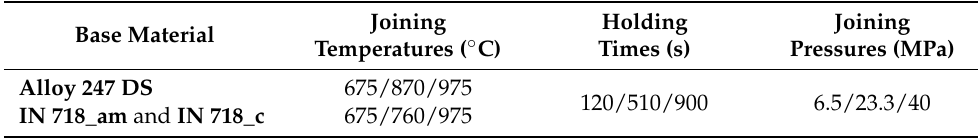
Table 3. Investigated parameter ranges for joining samples. Base Material